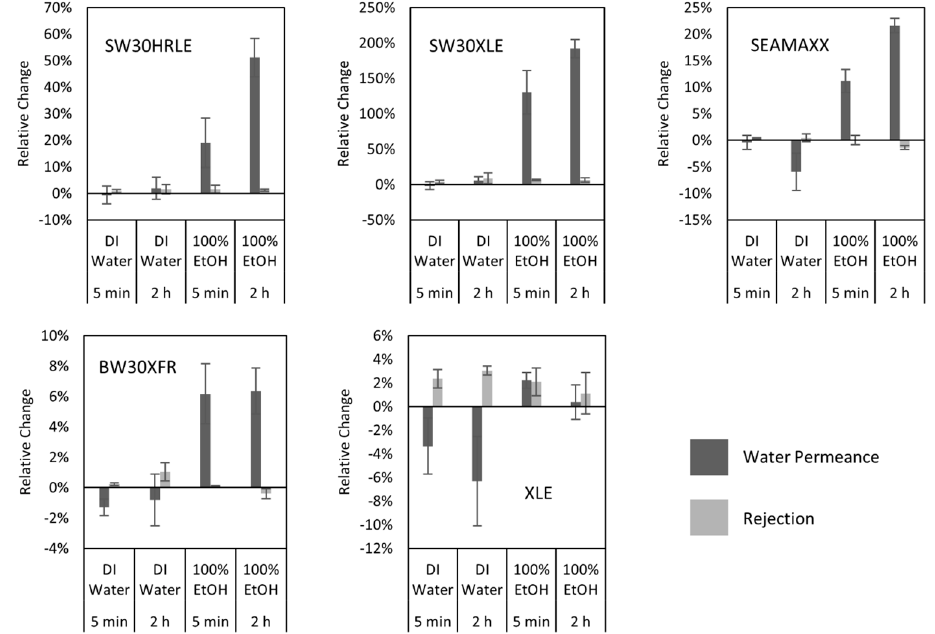
Figure 3. Relative change in water permeance ( dark ) and salt rejection ( light ) after water and ethanol contact for 5 min and 2 h for seawater ( top row ) and brackish water ( bottom row ) desalination membranes. Error bars represent one standard deviation for at least three measurements. Note that the y-axis scale is different for each membrane set.